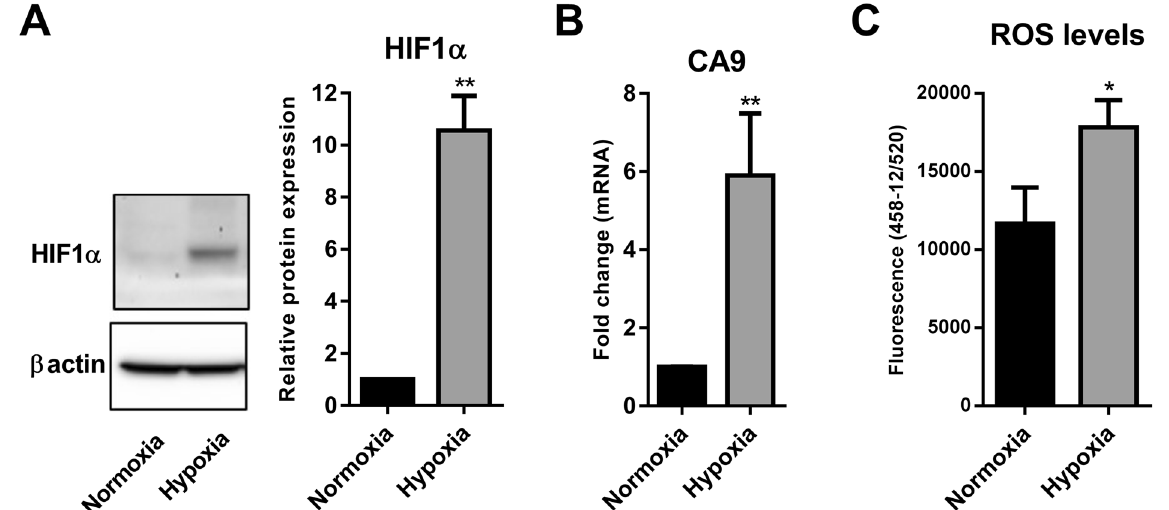
Figure 1. Hypoxia increases intracellular ROS levels. ( A ) Representative cropped immunoblot (left) and densitometry analysis (right) of HIF1 α protein levels in MDA-MB-468 cells exposed to hypoxia (6 h) compared to normoxic cells (full-lenght immunoblot is shown in the Supplementary Fig. S2). ( B ) CA9 mRNA levels in normoxic and hypoxic (24 h) cells were assessed using real time RT-PCR. ( C ) Intracellular levels of ROS measured by DCF-DA assay in cells exposed to hypoxia (12 h) compared to control cells (remained in normoxia). Graphs represent the mean ± SD for three independent experiments. * p < 0.05, ** p < 0.01 (unpaired